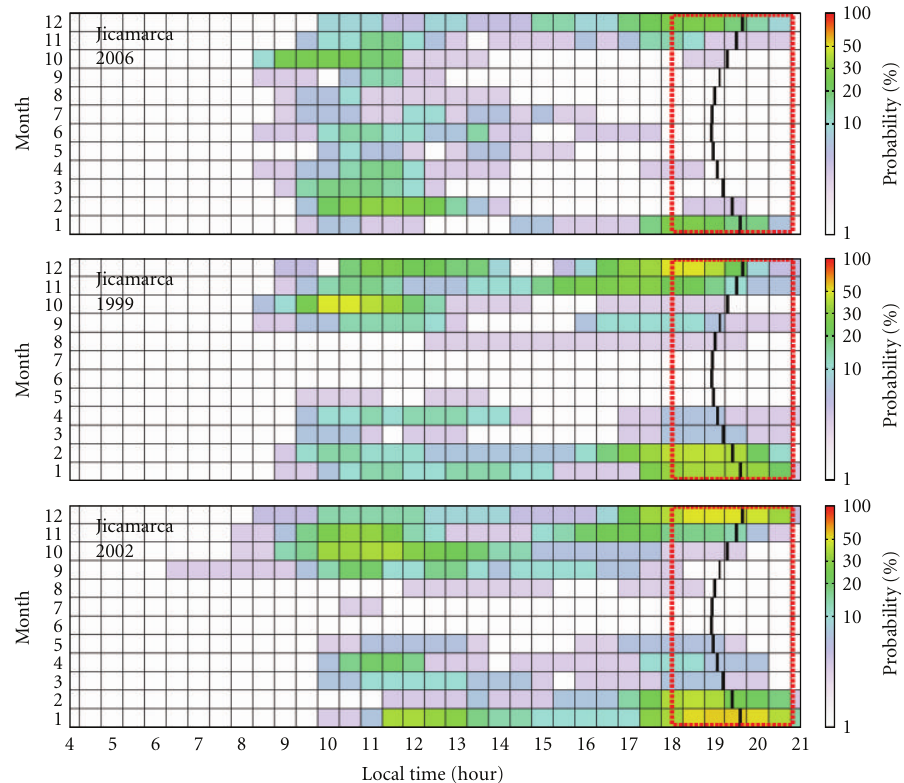
Figure 15: Occurrence probability of the F2 layer stratification at Jicamarca during low, medium, and high solar activity. The solar terminator around sunset (thick line) at 300 km is shown.